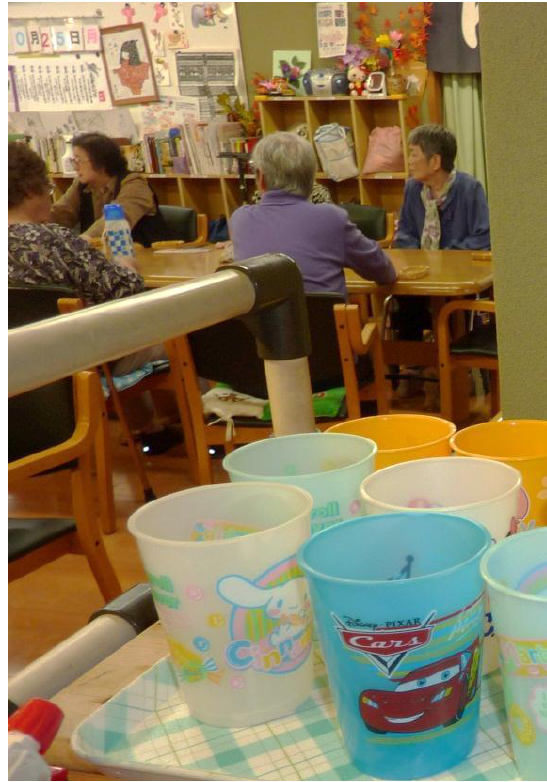
Figure 3. Water cups at the Day-Care Center Photo by the